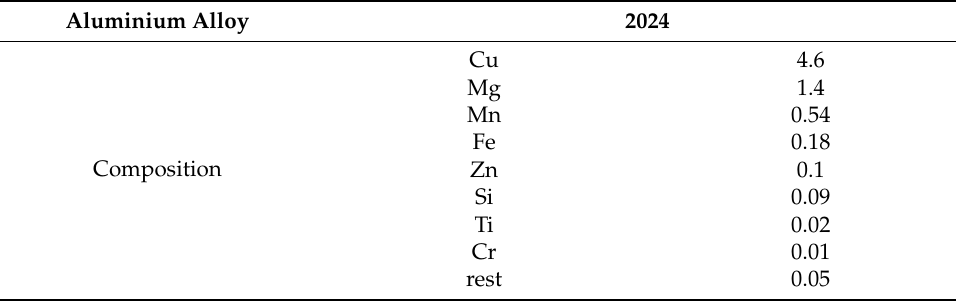
Figure 23. Universal moulder used in computer simulations. Table 12. Composition of aluminum alloys 2024.